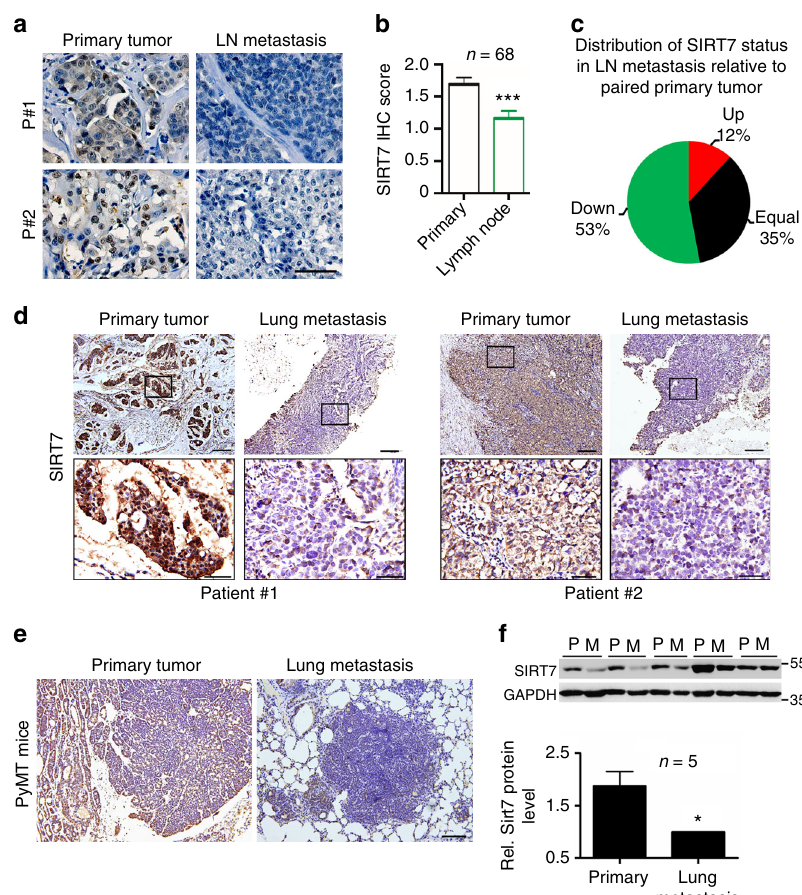
Fig. 1 SIRT7 is associated with breast cancer lung metastasis. a Representative immunohistochemical (IHC) staining of SIRT7 in primary breast tumors and paired lymph node metastases. Scale bar , 50 μ m. b Average SIRT7 IHC scores in primary breast tumors and lymph node metastases ( n = 68). c Percentage of SIRT7 expression distribution (up, down, or equal) in lymph node metastasis relative to the paired primary tumor. d Representative IHC staining of SIRT7 in primary breast tumors and paired lung metastases. Scale bar , 200 μ m ( upper ), 50 μ m ( lower ). e Representative IHC staining of SIRT7 in paired primary tumors and lung metastases in PyMT mice. Scale bar , 200 μ m. f Representative immunoblots showing Sirt7 expression in cells isolated from primary (P) and paired lung metastatic tumors (M) of PyMT mice ( n = 5). Relative Sirt7 protein levels were quanti fi ed by Image J. Data are shown as mean ± S.E.M. * P < 0.05, *** P < 0.001. P- values are calculated by Student ’ s t